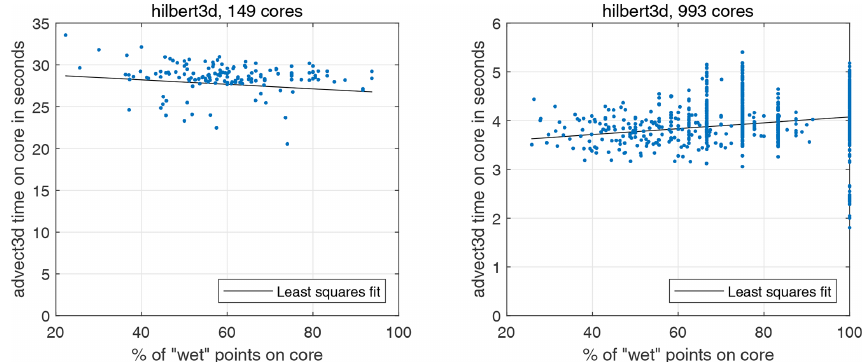
Figure 5. Scatter plot: percentage of wet points on a core – advect3D runtime (without MPI exchanges for 1 model day). Each point corresponds to one CPU core. Figures correspond to the hilbert3d partition with different numbers of CPU cores.